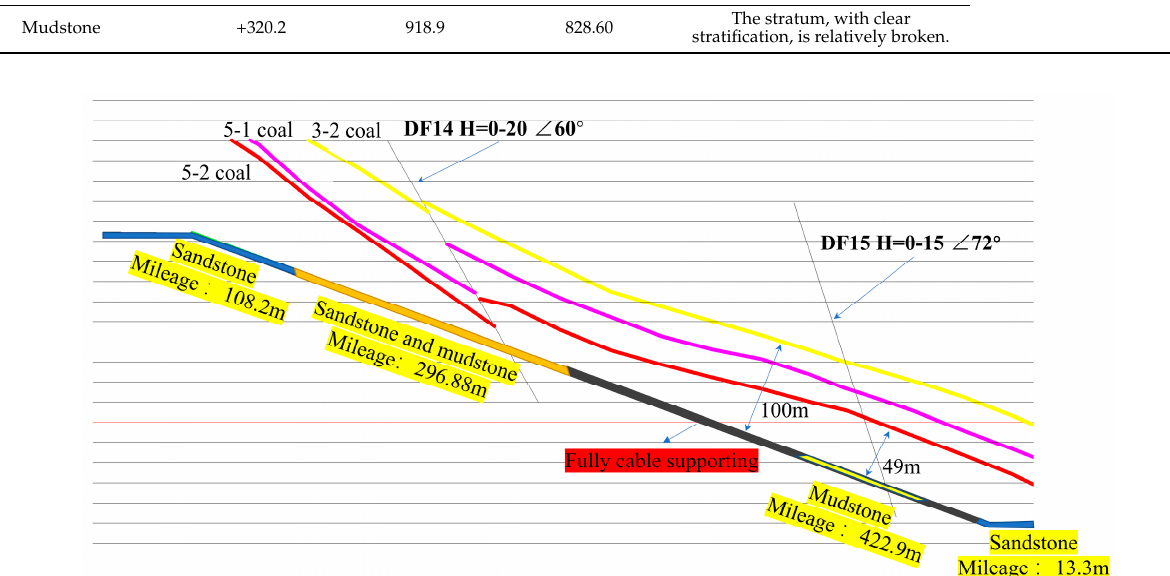
Figure 1. Lithology distribution of the surrounding rock in the return air subinclined shaft.